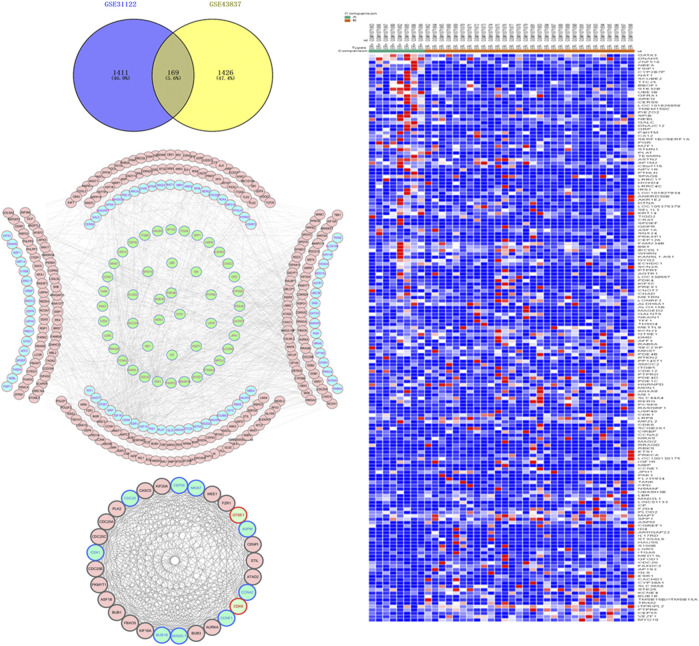
Acquisition of differentially expressed genes (DEGs) and construction of protein interaction network in estrogen receptor (ER)-positive and ER-negative breast cancer. (A) Overlapping 169 DEGs were identified from two microarray data profiles (GSE31192, GSE43837). Blue represents 2,153 DEGs identified from GSE31192 chip, and yellow represents 1,689 DEGs identified from GSE43837 chip. The intersection areas represent 169 common DEGs. (B) Based on the GSE43837 chip data composed of eight ER positive samples and 30 ER negative samples, Heat maps of 169 DEGs are drawn. The color from blue to red shows a trend from low expression to high expression. Protein interaction network construction and module analysis of 169 DEGs, 169 DEGs related genes were also included in the mapping. (C) The protein interaction network of 169 genes, including 334 nodes and 1,298 edges. (D) The most significant module in the network, including 29 nodes and 306 edges. Blue represents the down-regulated DEGs, green represents the up-regulated DEGs, and red represents the 169 DEG-related genes obtained in String.